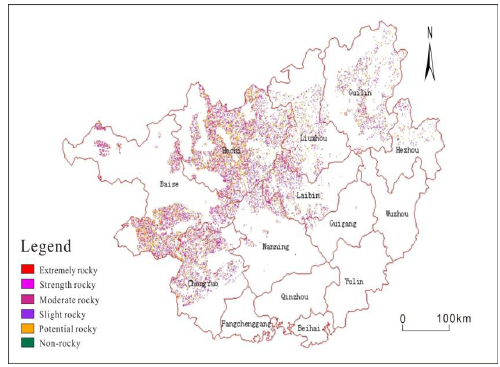
Figure 7. Guangxi rocky hierarchical diagram 3.3.3 The results: The statistical results of each grading rocky classification (Table 3) showing that, the whole Guangxi rocky area of about 22,000 km2, accounting for about 9% of the land area of Guangxi.